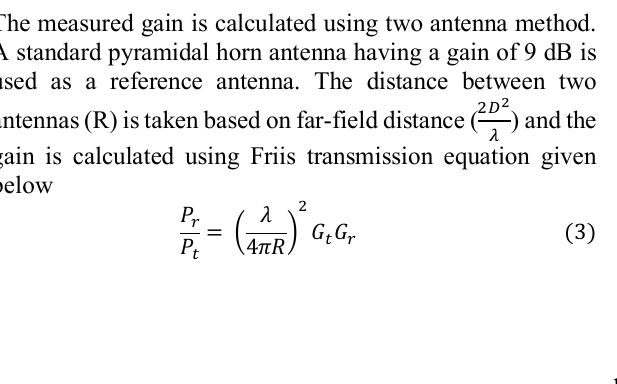
Figure 6: Simulation and Measured 2-D radiation pattern at 2.7 GHz in LP state (a) xz-plane (b) yz-plane